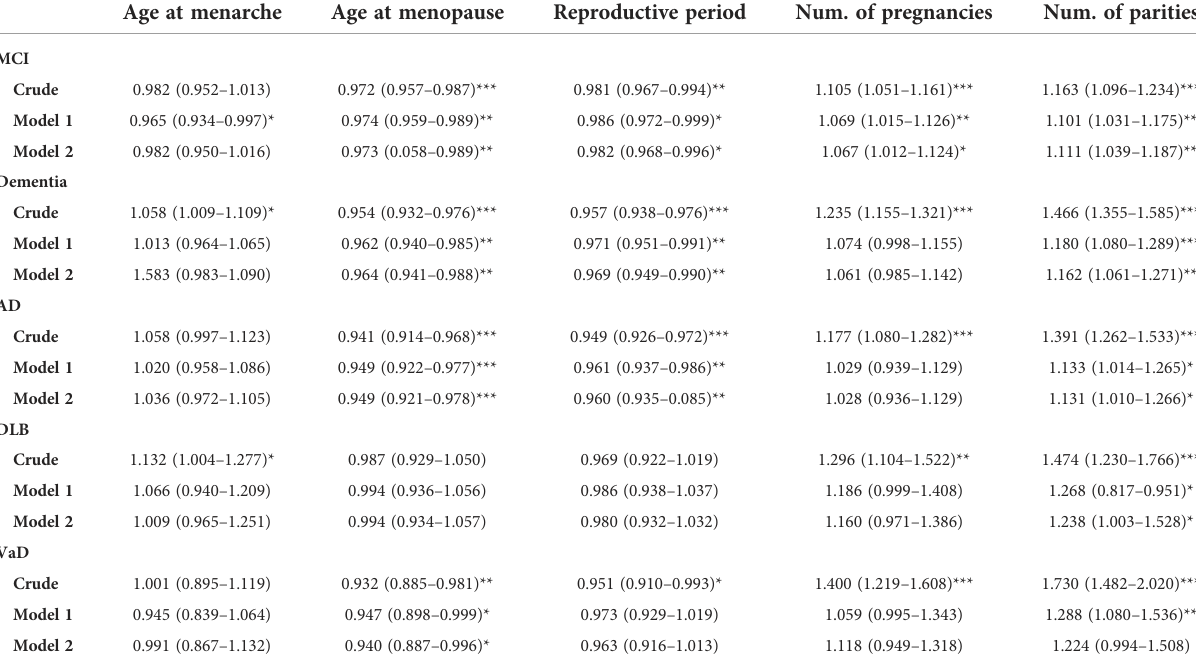
TABLE 4 Association between reproductive factors and risks of cognitive impairment by logistic regressions (ORs with 95% CI). Age at menarche Age at